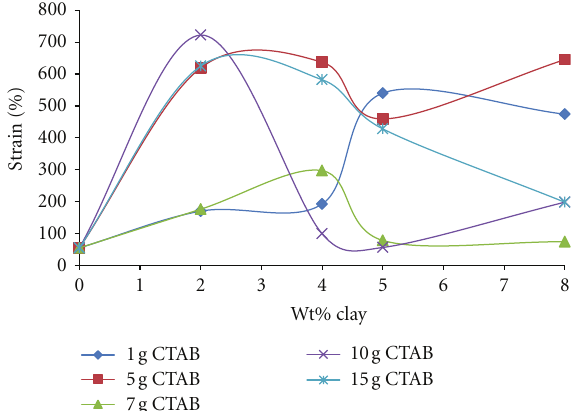
Figure 14: The change of yield strength of produced PEO/clay nanocomposites at various CTAB/clay ratios with organo-clay contents.